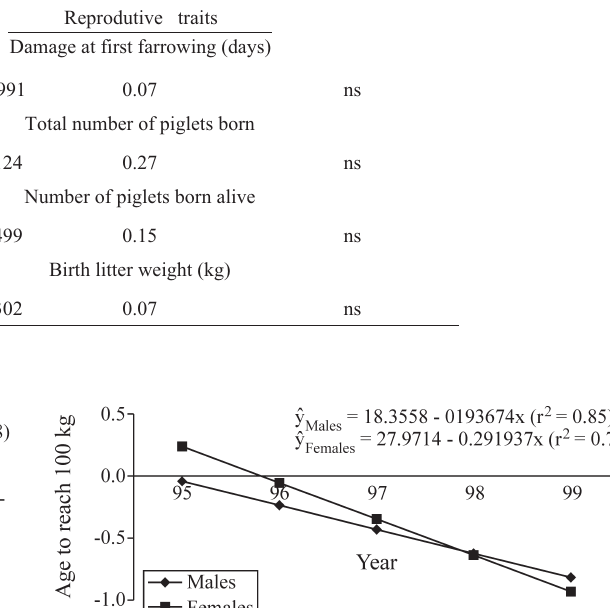
Table 1 - Genetic trend estimates ( additive genetic effect.